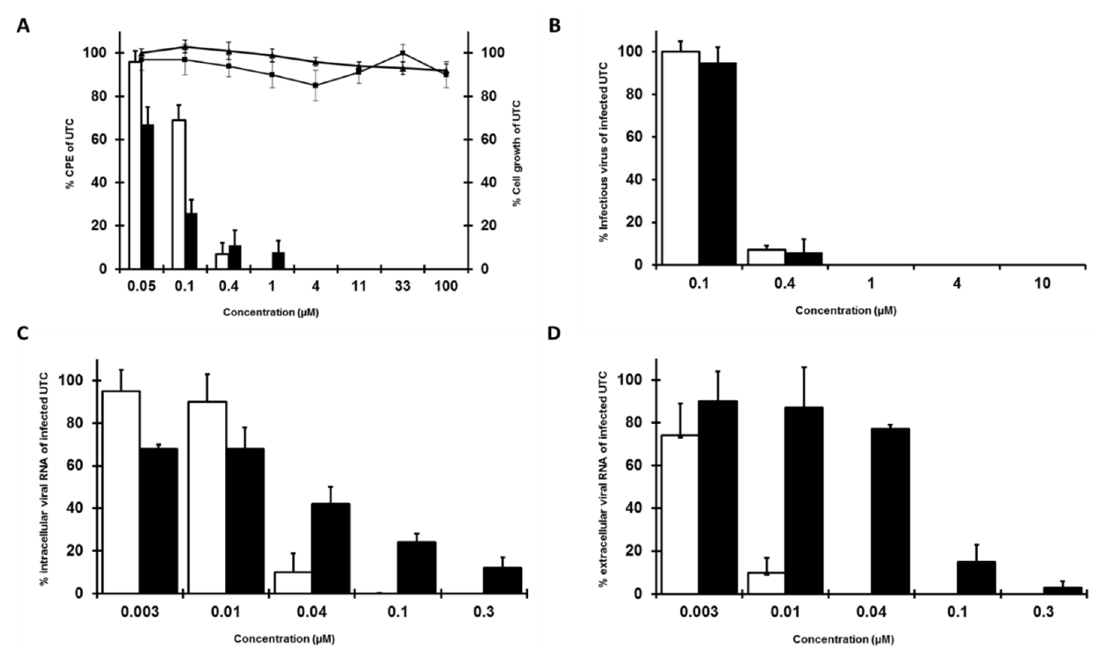
Figure 2. Effect of TO502-2403 (CSFCII, open bars, diamonds) or TO505-6180 (CSFCI, black bars, squares) on ( A ) BVDV (NADL)-induced cytopathic effect (CPE) formation in the MDBK cells (bars) and on the proliferation of exponentially growing Madin–Darby (MDBK) cells TO502-2403 (CSFCII, diamonds) or TO505-6180 (CSFCI, squares), ( B ) on infectious virus yield, ( C ) on intracellular viral RNA, and ( D ) on the release of extracellular viral RNA.